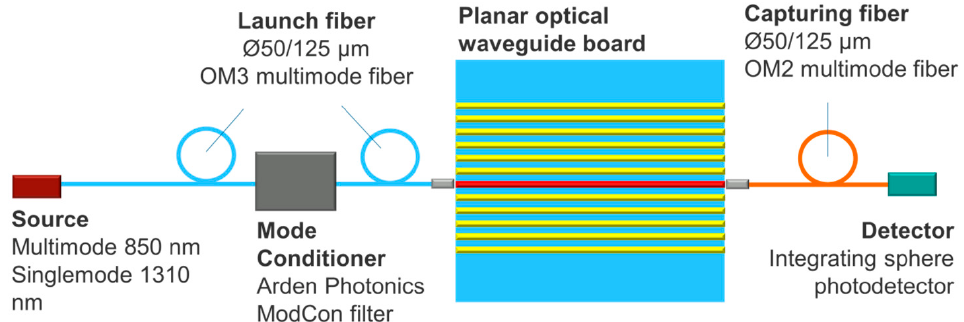
Figure 10. Measurement schematic of the multimode fiber launch.